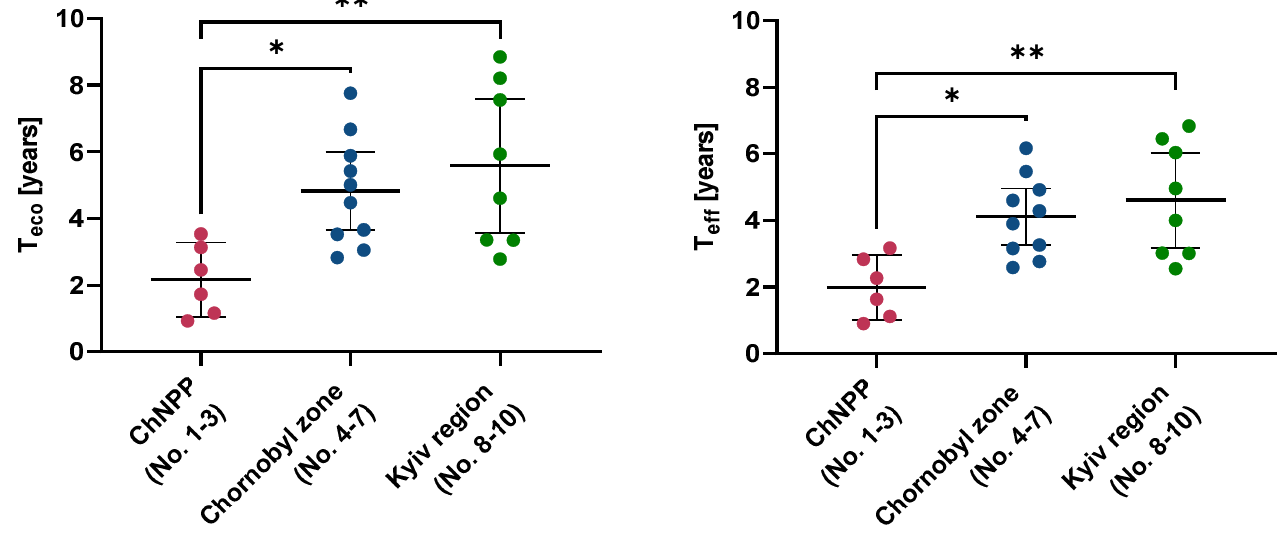
Figure 3. T eco ( left ) and T eff ( right ) values of symbiotrophic fungi according to the sampling site